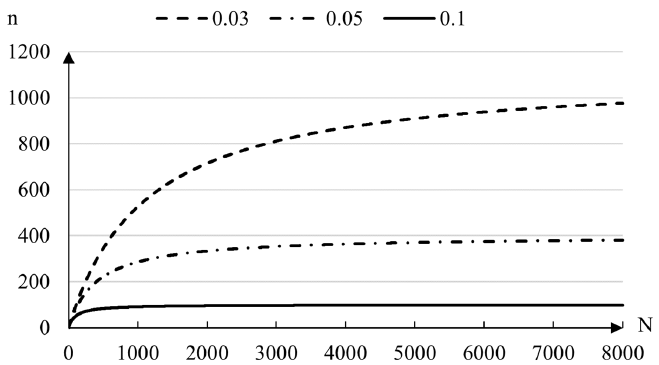
Figure 3. Correlation of the number of samples and population size using Yamane’s equation with three different margins of error (0.03, 0.05, 0.1). three different margins of error (0.03, 0.05,